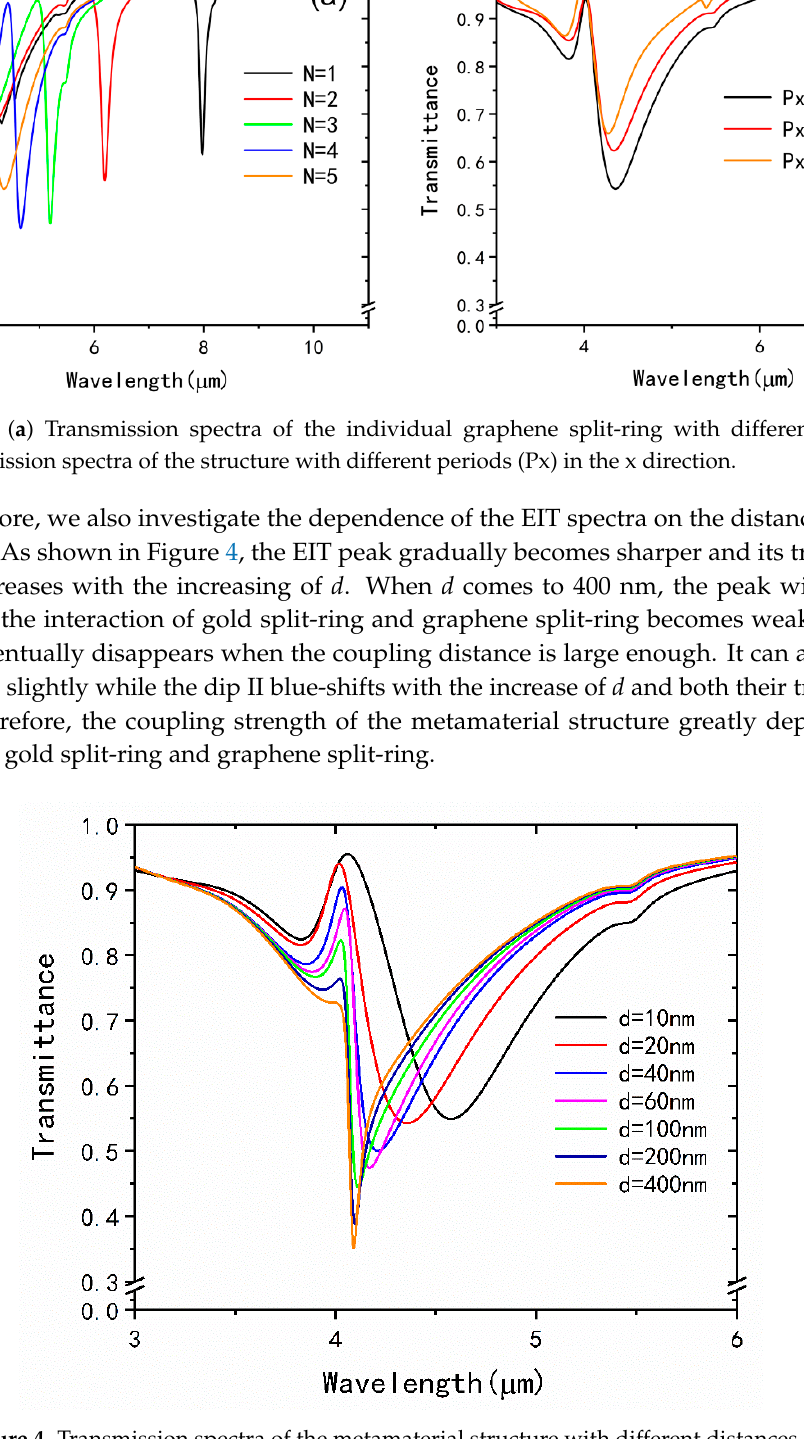
Figure 4. Transmission spectra of the metamaterial structure with different distances d .